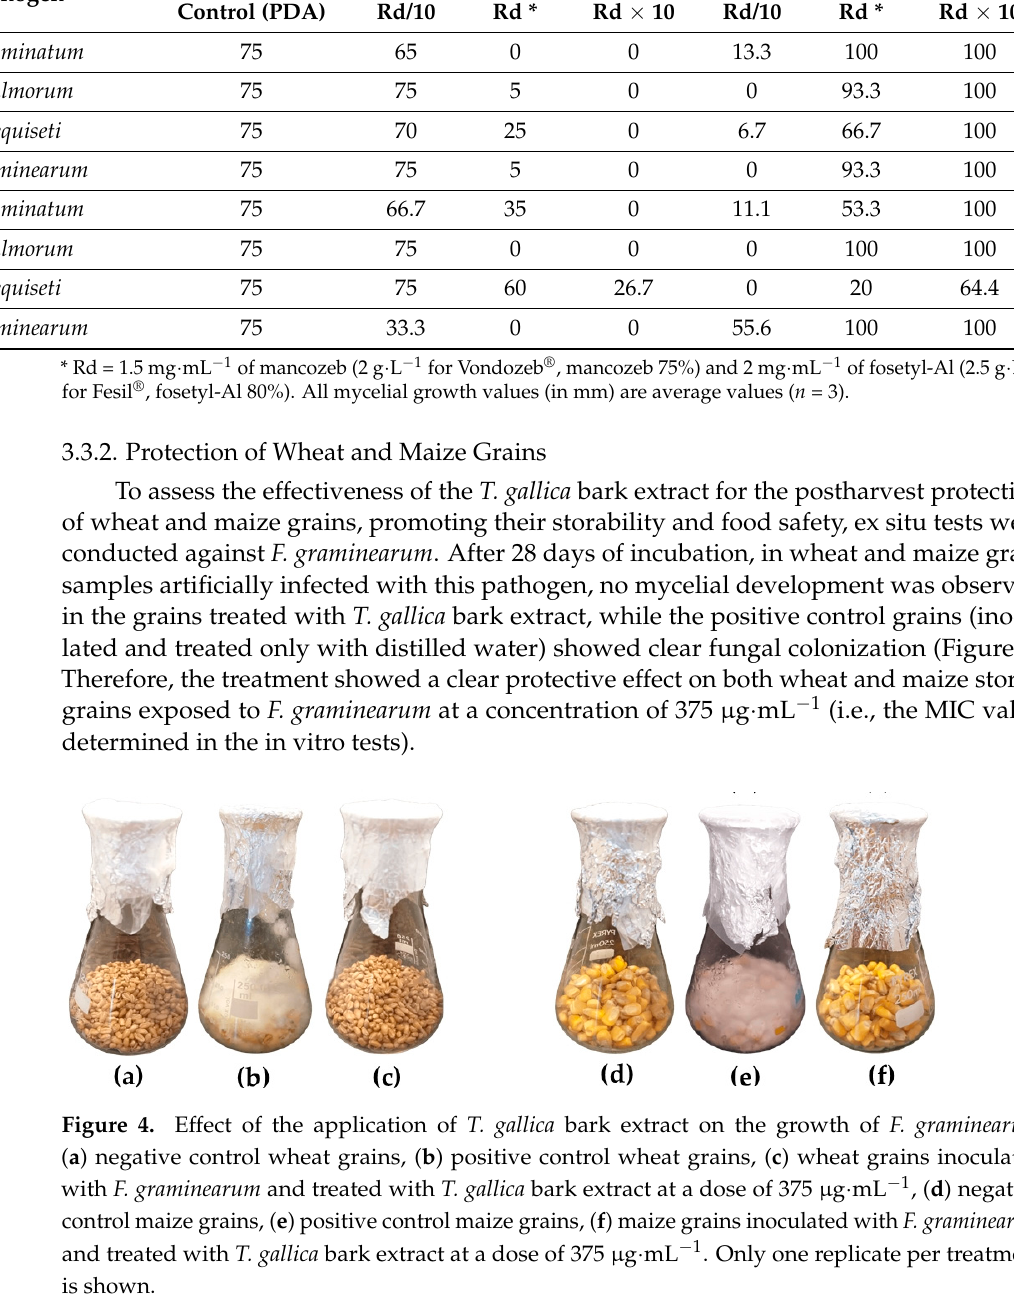
Figure 5. Germination tests: ( a ) wheat grains treated with T. gallica bark extract at a dose of 375 μ g·mL − 1 ; ( b ) positive control wheat grains (inoculated with F. graminearum and treated with distilled water); ( c ) wheat grains inoculated with F. graminearum and treated with T. gallica bark extract at a dose of 375 μ g·mL − 1 ; ( d ) maize grains treated with T. gallica bark extract at a dose of 375 μ g·mL − 1 ; ( e ) positive control maize grains (inoculated with F. graminearum and treated with distilled water); and ( f ) maize grains inoculated with F. graminearum and treated with T. gallica bark extract at a dose of 375 μ g·mL − 1 . Only one replicate per treatment is shown. 4. Discussion 4.1. On the Phytochemical Composition and Mode of Action The high phenolics content is in agreement with that reported in flowers by Boulaaba et al. [29] (135.3 mg GAE/g DW) and would explain the high antioxidant activity observed by Nisar et al. [30] and by Lefahal et al. [31].